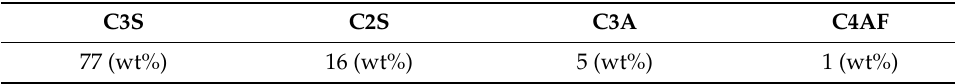
Table 1. Mineralogical phases of white cement.